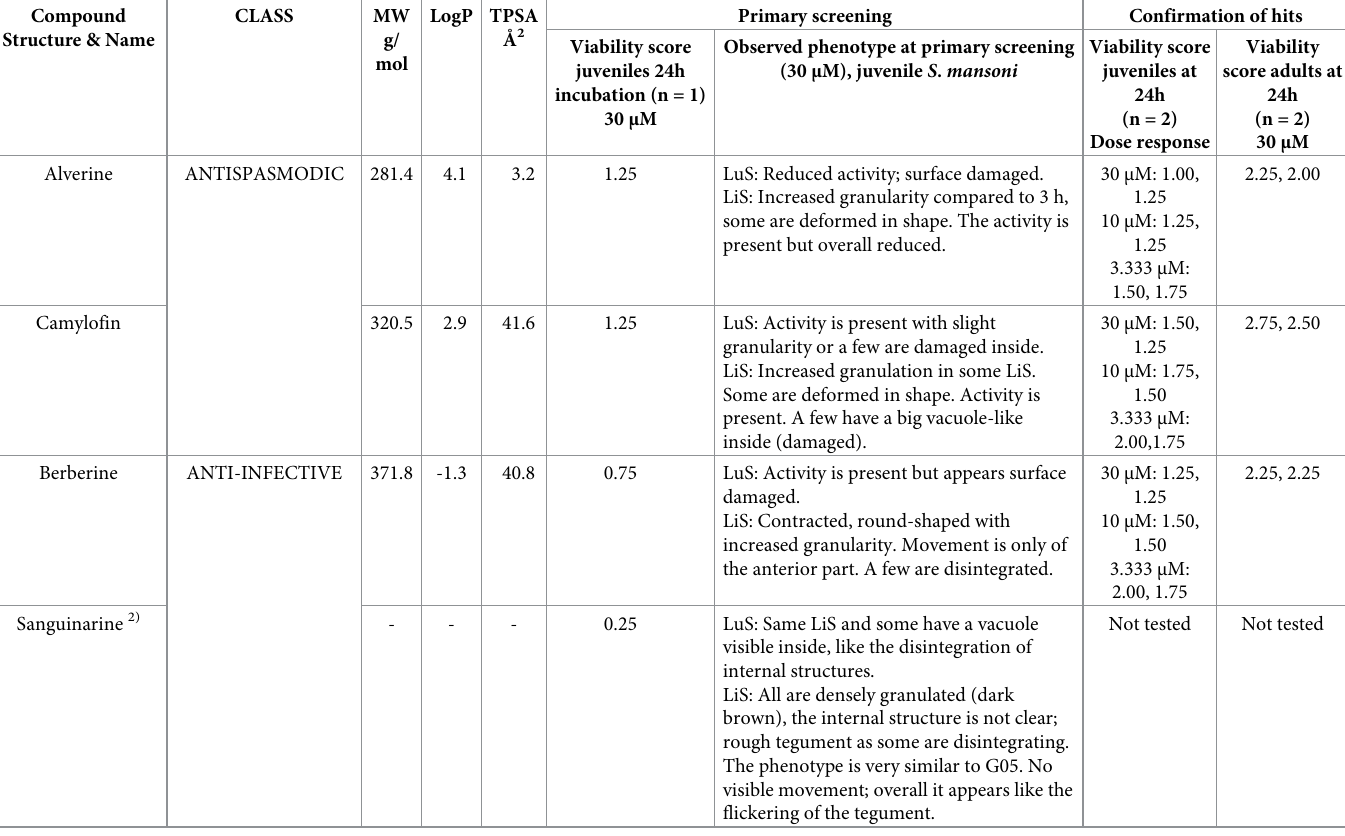
tube and centrifuged for 10 min at 5000 x g at 22˚C. The supernatant containing the culture medium was discarded. Samples were treated to series of sequential steps: Fixation (4% glutar- aldehyde and 0.2 M cacodylate), 1 st wash (0.4 M saccharose / 0.2 M cacodylate), post-fixation